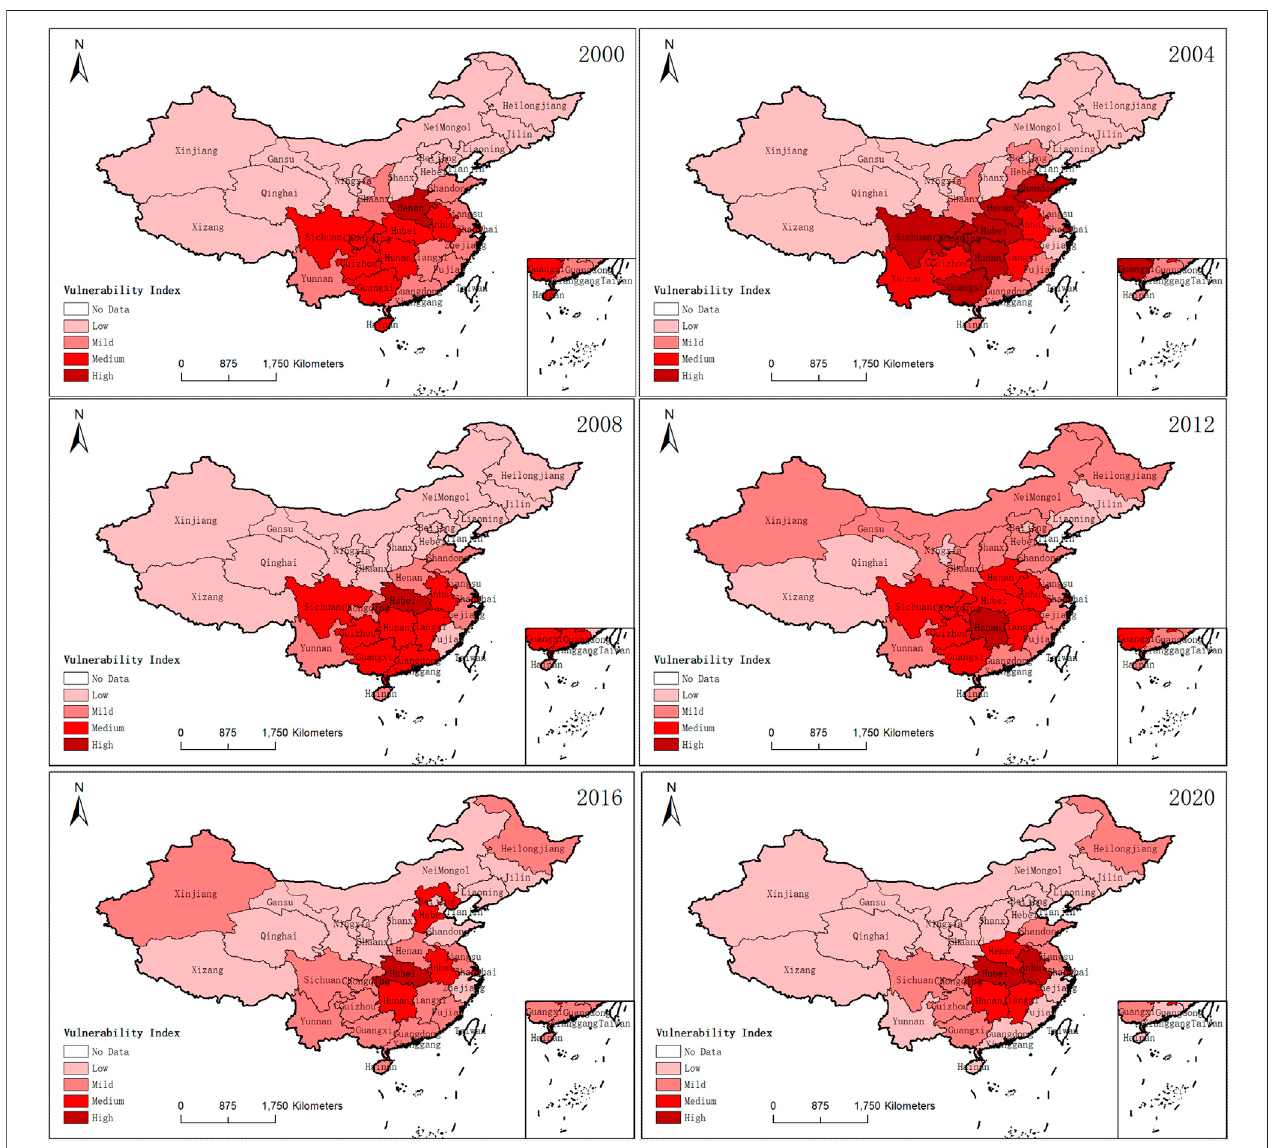
FIGURE 1 | Temporal and spatial variation of agricultural fl ood vulnerability in